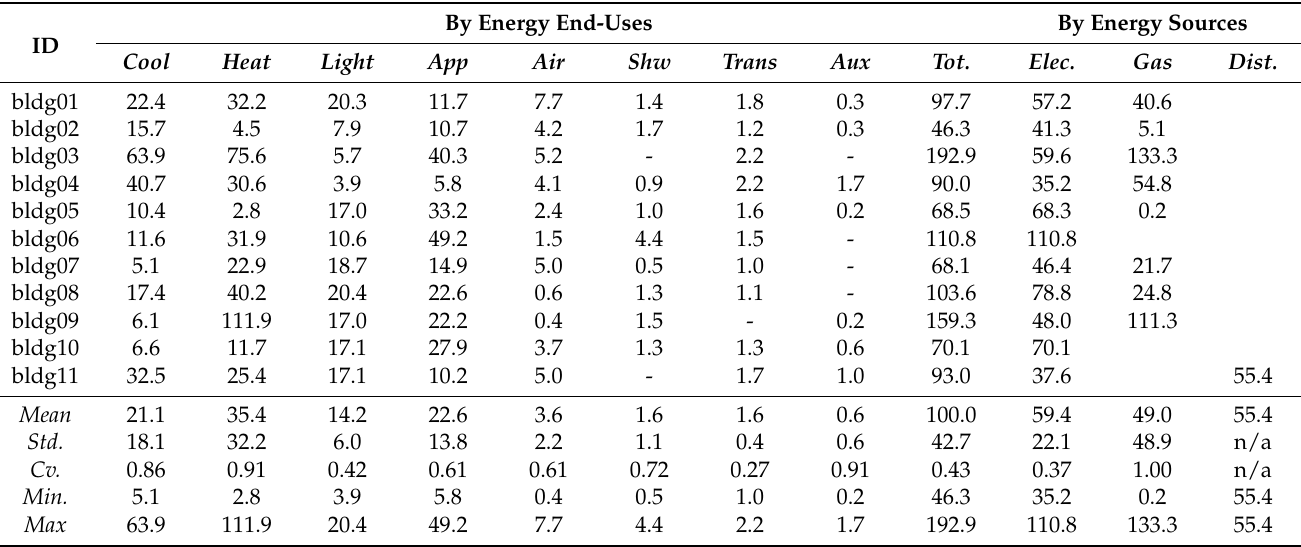
Table A1. Measured energy consumption (kWh/m 2 ) and descriptive